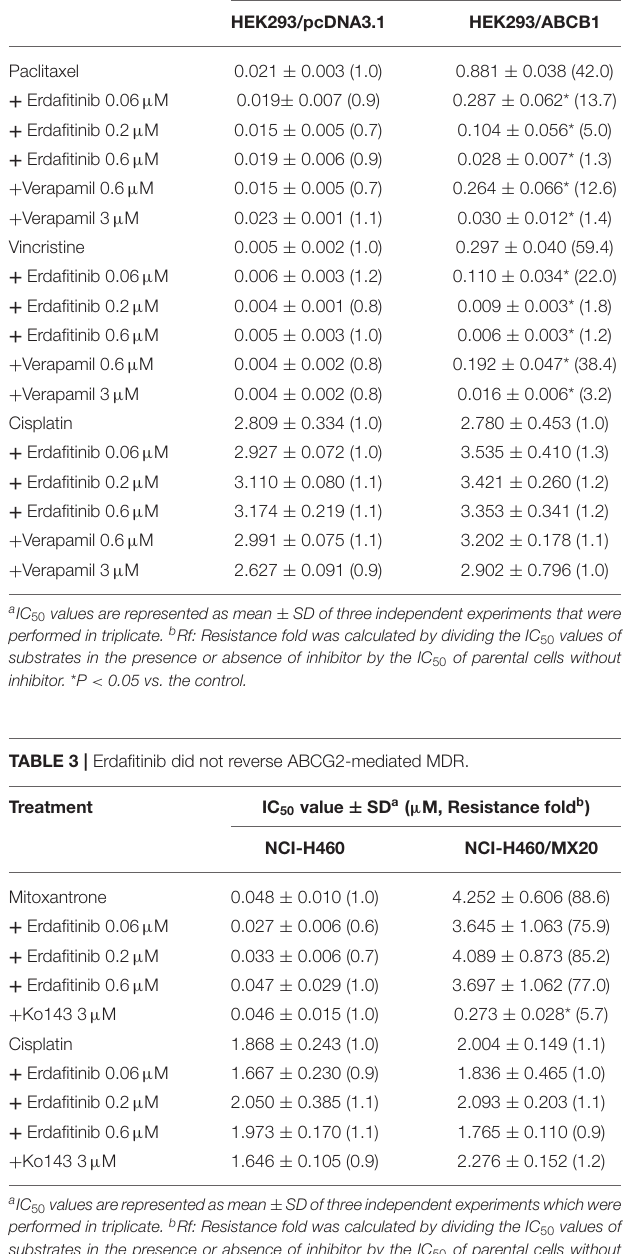
TABLE 2 | Erdafitinib reversed ABCB1-mediated MDR in HEK293/ABCB1 cells. Treatment